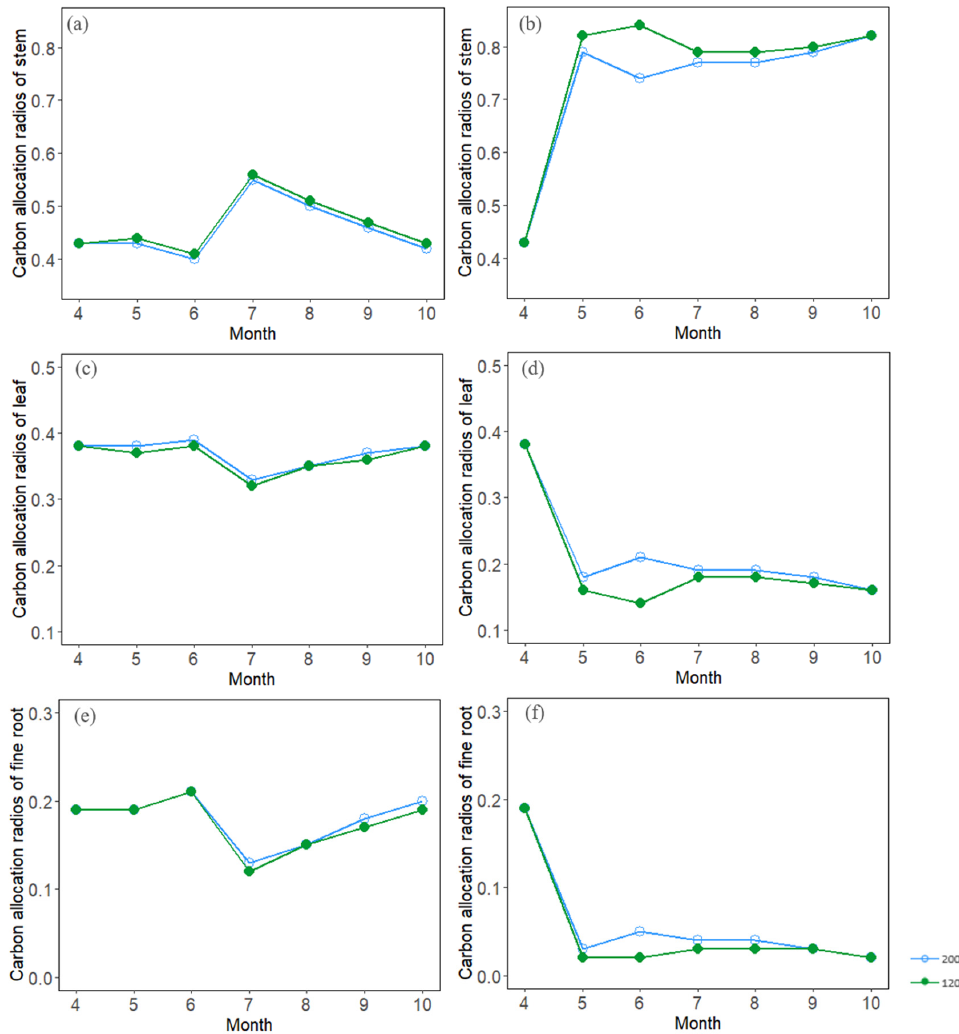
Figure 4. Simulated seasonal dynamics of the carbon allocation ratio to stems ( a , b ), foliage ( c , d ), and fine roots ( e , f ) for the 6-year-old ( a , c , e ) and 13-year-old ( b , d , f ) stands with different densities (200 vs. 1200 stems ha − 1 ) using the modified model. 1200 stems ha − 1 ) using the modified model.